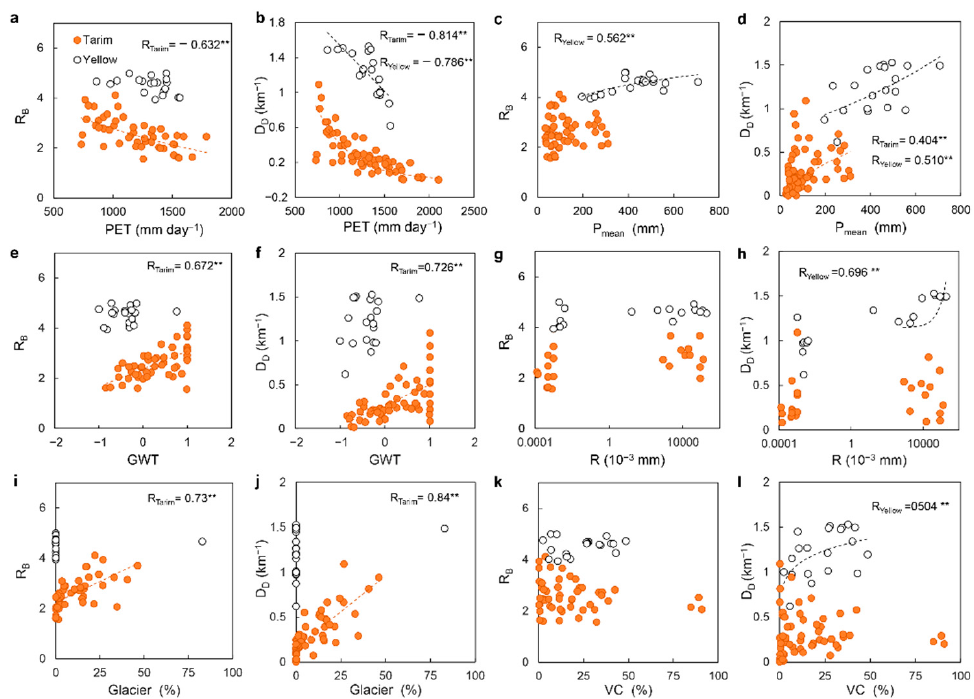
Figure 9. Relations between structural parameters (R B , D D ) of river networks and basin factors including ( a , b ) PET, ( c , d ) P mean , ( e , f ) GWT, ( g , h ) R, ( i , j ) Glacier, and ( k , l ) VC for representative sub-basins in the Tarim (orange dot) and the Yellow River basins (black hollow dot) (** p < 0.01; Spearman correlation).